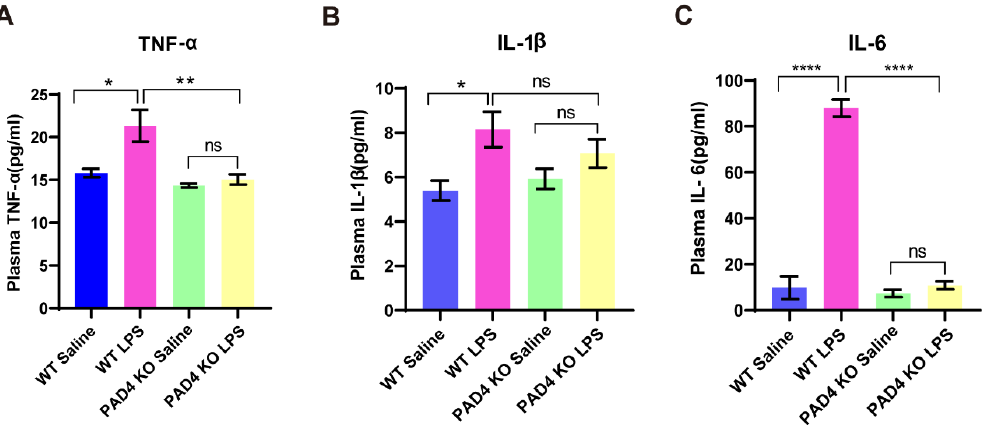
Figure 3. The level of plasma proinflammatory cytokines after LPS treatment. ( A – C ) The levels of plasma TNF- α , IL-1 β and IL-6. Data were expressed mean ± SEM. * p < 0.05, ** p < 0.01, **** p < 0.0001. WT Saline, PAD4 KO Saline, PAD 4 KO LPS: n = 6; WT LPS: n = 9.